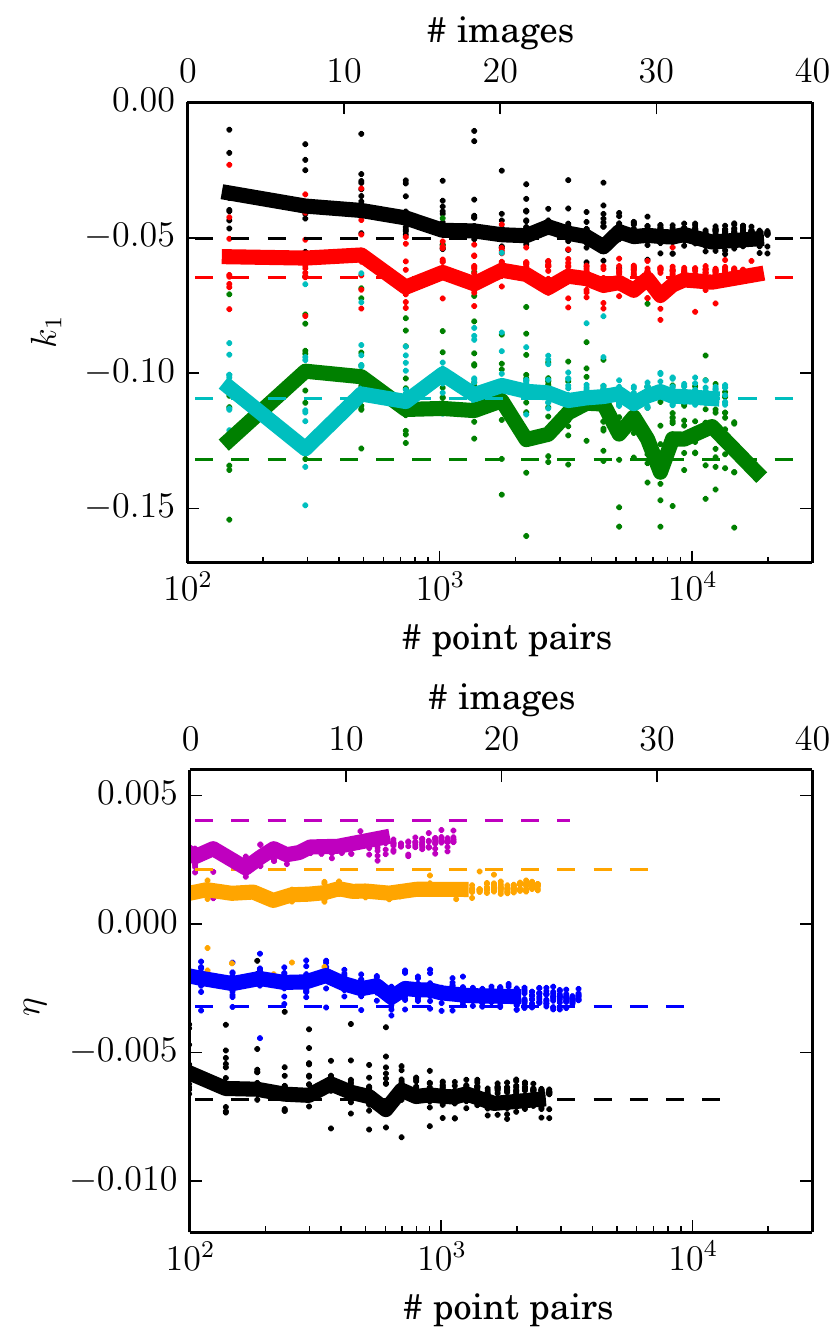
Figure 5. Convergence of the value of η as a function of the number of inlier point pairs (and number of images). Note that as the checkerboard images form a connected network, a set of five or 20 images equals about 490 or 9310 point pairs, respectively. In other words, the amount of point pairs grows exponentially with respect to the amount of images. The dashed lines represent reference results onto which the results from EPOS (solid lines) converge. The previous, in top to bottom order, are ( a ) Nikon D700 24 mm, Olympus 14 mm, Nikon D7100 18 mm, Panasonic DMC 6 mm; ( b ) results for four different zoom settings, 24 mm, 28 mm, 35 mm and 50 mm, for Nikon D700 (bottom to top order). Note the different units for η and k 1 ; see the text for